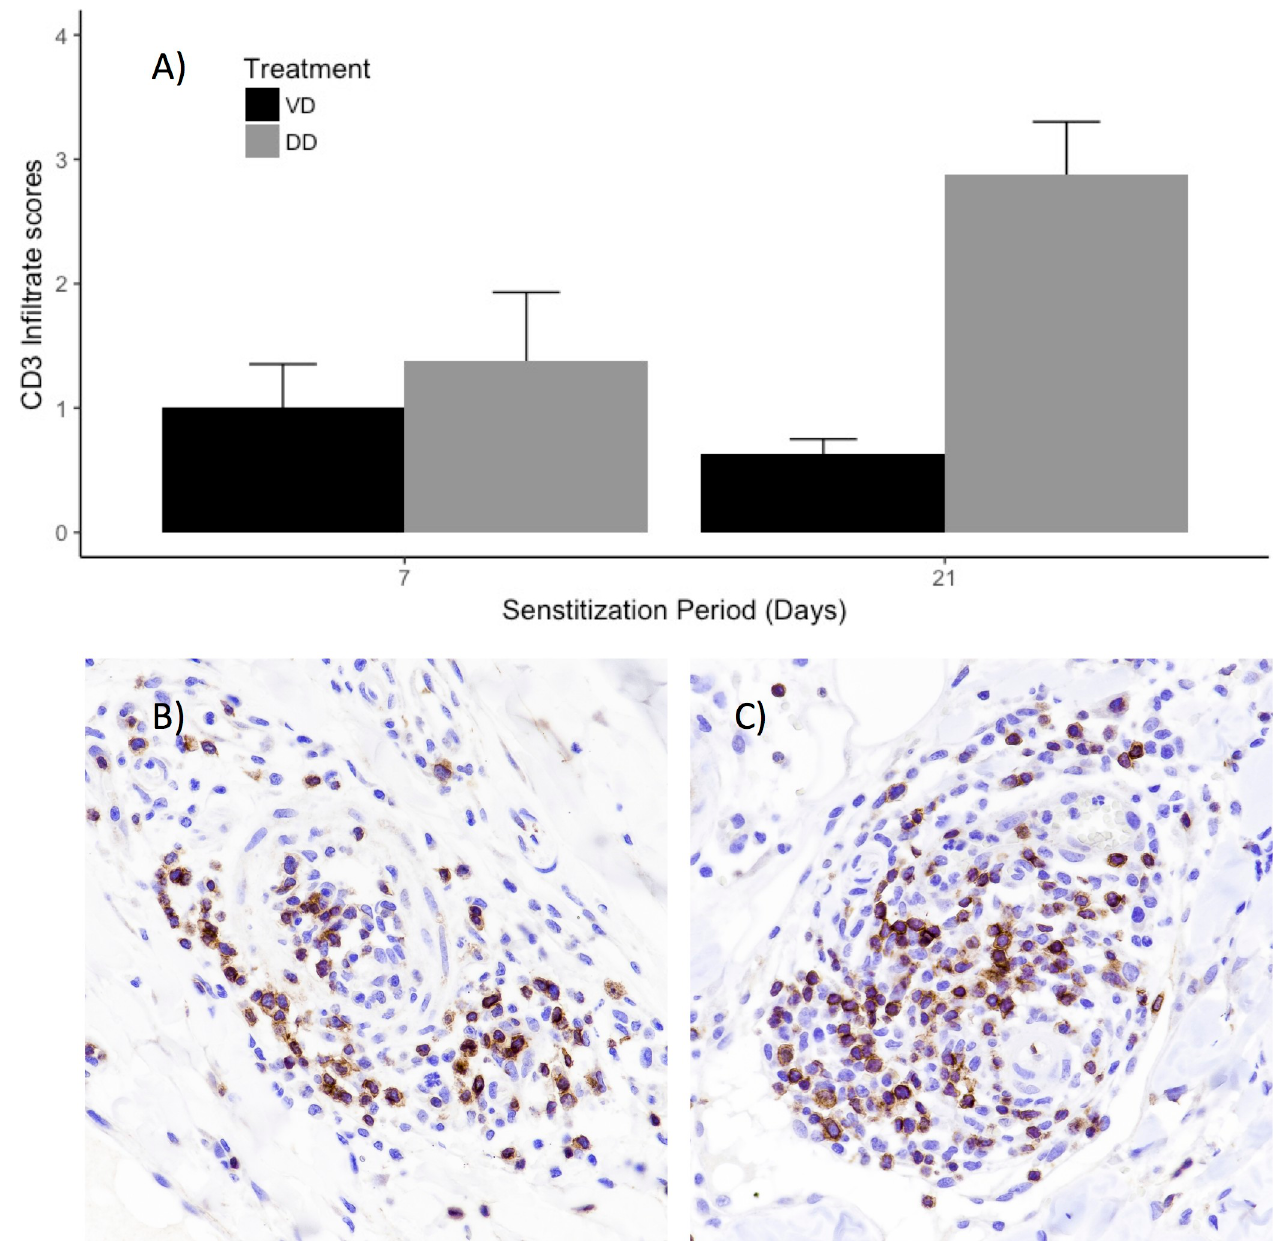
Fig 6. CD3 Immunohistochemistry staining and pathology scores of ear sections from VD and DD hapten treated animals (7 and 21 day sensitization period). A pathologist scored CD3 positive cell infiltrates on a 0–4 scale for VD (black bars) and DD (gray bars) for 7 and 21 day sensitization periods (A). Shown are representative images of CD3 stained DD ear sections from 7 day sensitization (B), and 21 day sensitization periods (C).